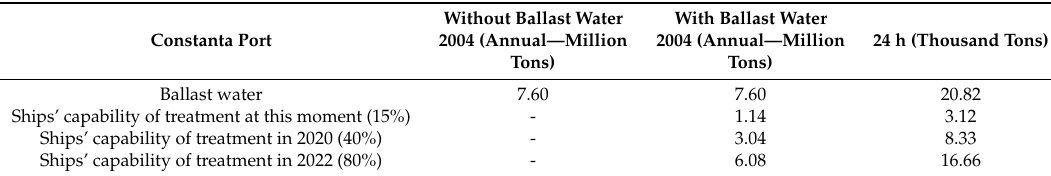
Table 5. Constanta harbor’s capability of ballast water